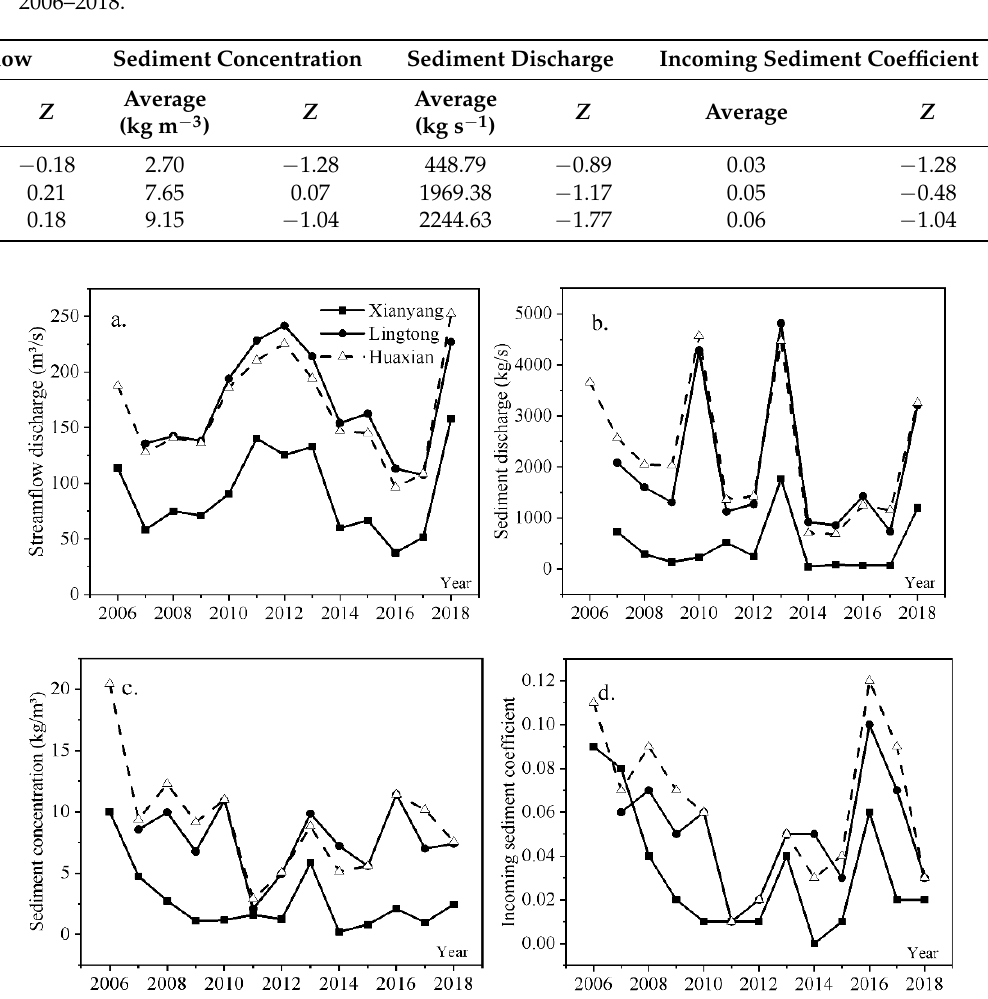
Figure 8. Variation of annual ( a ) streamflow discharge, ( b ) sediment discharge, ( c ) sediment concentration, and ( d ) incoming sediment coefficient in the lower Weihe River in 2006 – 2018. Inra − year water − sediment variation. According to Table 3, the multi − year average runoff volumes of Xianyang, Lintong and Huaxian stations were 114.00 m 3 /s, 207.14 m 3 /s and 206.12 m 3 /s, respectively; the sediment concentrations were 14.75 kg/m 3 , 15.87 kg/m 3 and 16.80 kg/m 3 , respectively; the sediment discharge were 856.73 kg/s, 3806.64 kg/s and 3975.79 kg/s, respectively; the average incoming sediment coefficients were 0.056, 0.090 and 0.102, respectively. Combined with the streamflow − sediment change diagram in Figure 9 and the Mann – Kendall trend test results in Table 3, it can be seen that the trends of flood runoff, sediment concentration, sediment discharge, and incoming sediment coefficient of the three hydrological stations and the inter − annual change trends were